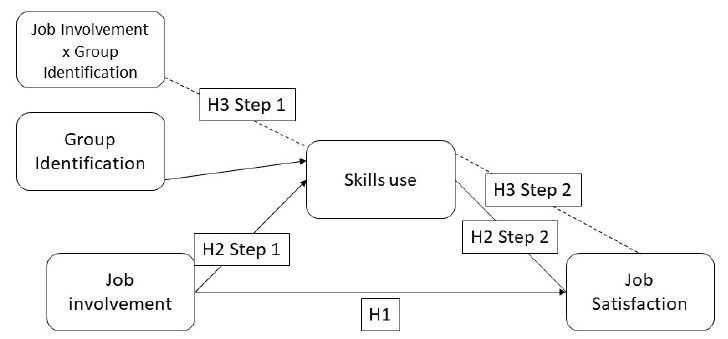
Figure 1. Hypothesis’ graphical model showing the relationships between variables.